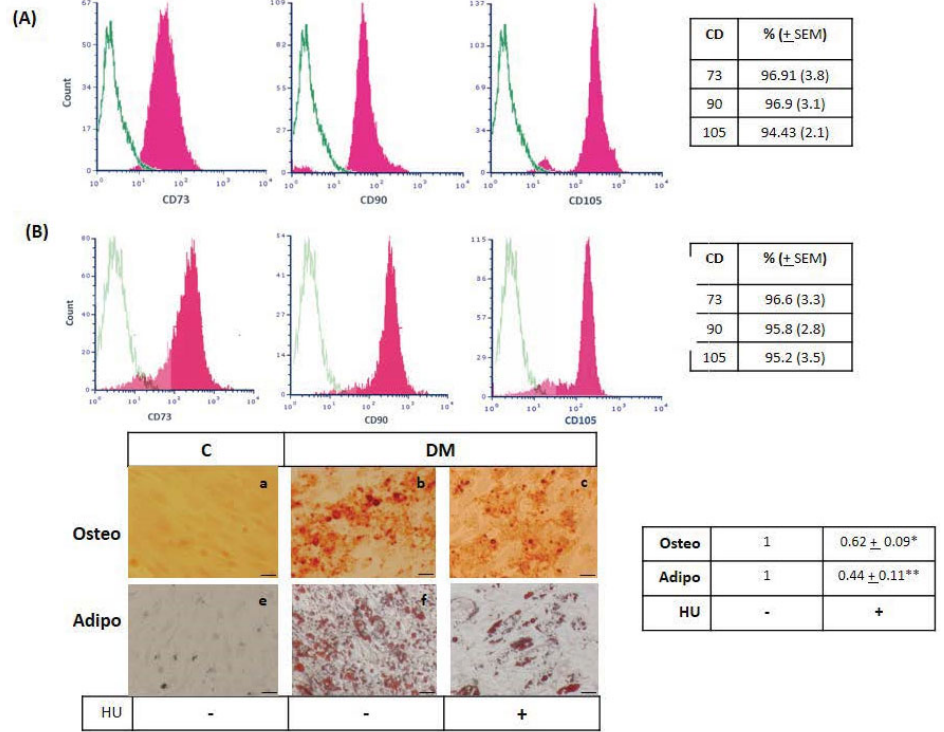
Figure 4. Hydroxyurea inhibits BMMSC differentiation. BM MSC were cultured for 3 days without ( A ) or with ( B ) 200 μ M HU and subjected to MSC CD73, CD90 and CD105 surface markers determination by flow cytometry analysis. Green line indicated fluorescence obtained with isotype control. ( C ) Subjected to osteogenic (Osteo) and adipogenic (Adipo) differentiation and determined by alizarin red and oil ‐ red staining respectively. ( a , e ) non ‐ differentiated control cells, ( b , f ) osteogenic differentiation, and ( c , g ) adipogenic differentiation. Table indicates the differentiation level compared to BMMSC without HU treatment (value = 1). Magnification 40×, Bars = 10 μ m. Results presented are representative from at least 3 performed experiments. Significant difference control cells by t ‐ test: p < 0.05 (*) and p < 0.005 (**).